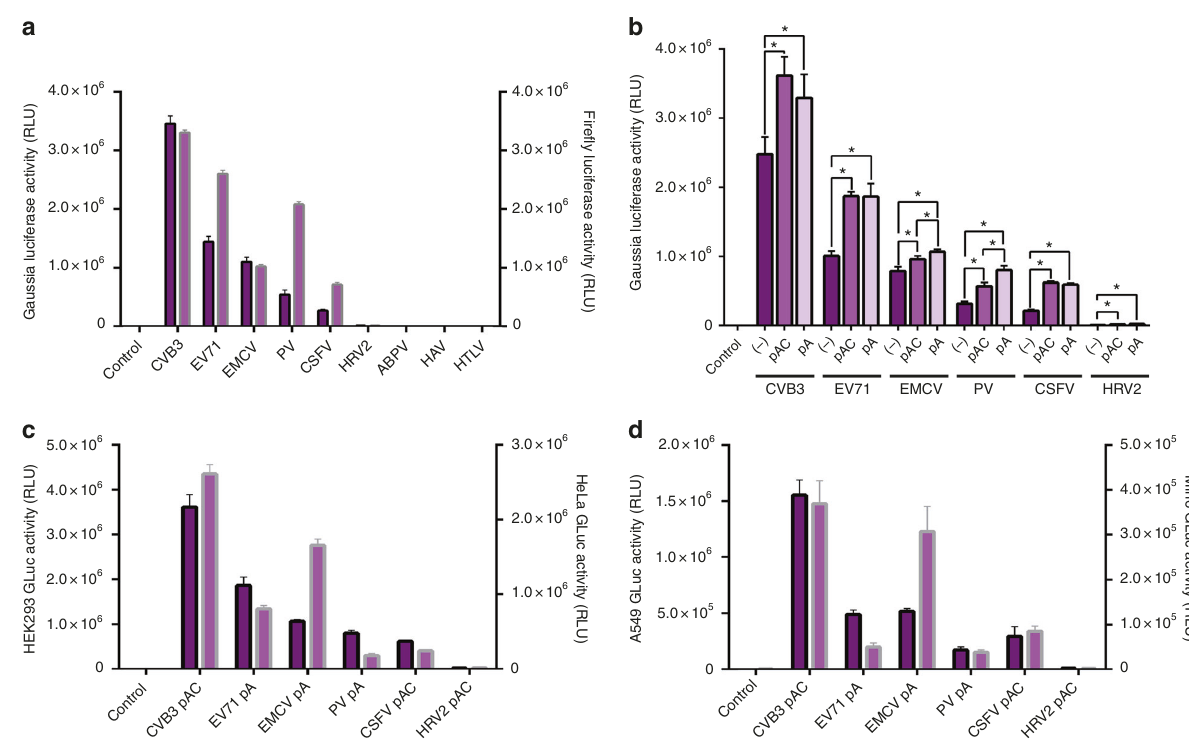
Fig. 4 IRES ef fi cacy in varying cell and sequence contexts. a Luminescence in the supernatant of HEK293 cells 24 h after transfection with circRNA containing a panel of viral 5 ′ UTR IRES sequences in GLuc (left axis, dark purple with black outline) and FLuc (right axis, light purple with gray outline) contexts. b Luminescence in the supernatant of HEK293 cells 24 h after transfection with circRNA containing an added polyA(30) or polyAC(30) spacer sequence separating the IRES from the splice junction. ( − ): no spacer. pAC: 30nt spacer consisting of adenosines and cytosines. pA: 30nt spacer consisting of adenosines. c Luminescence in the supernatant of HEK293 (left axis, dark purple with black outline) and HeLa (right axis, light purple with gray outline) cells 24 h after transfection with the most effective circRNAs by IRES in ( b ). d Luminescence in the supernatant of A549 (left axis, dark purple with black outline) and Min6 (right axis, light purple with gray outline) cells 24 h after transfection with the most effective circRNAs by IRES in ( b ) (all data presented as mean + SD, n = 4, * p < 0.05 (Welch ’ s t